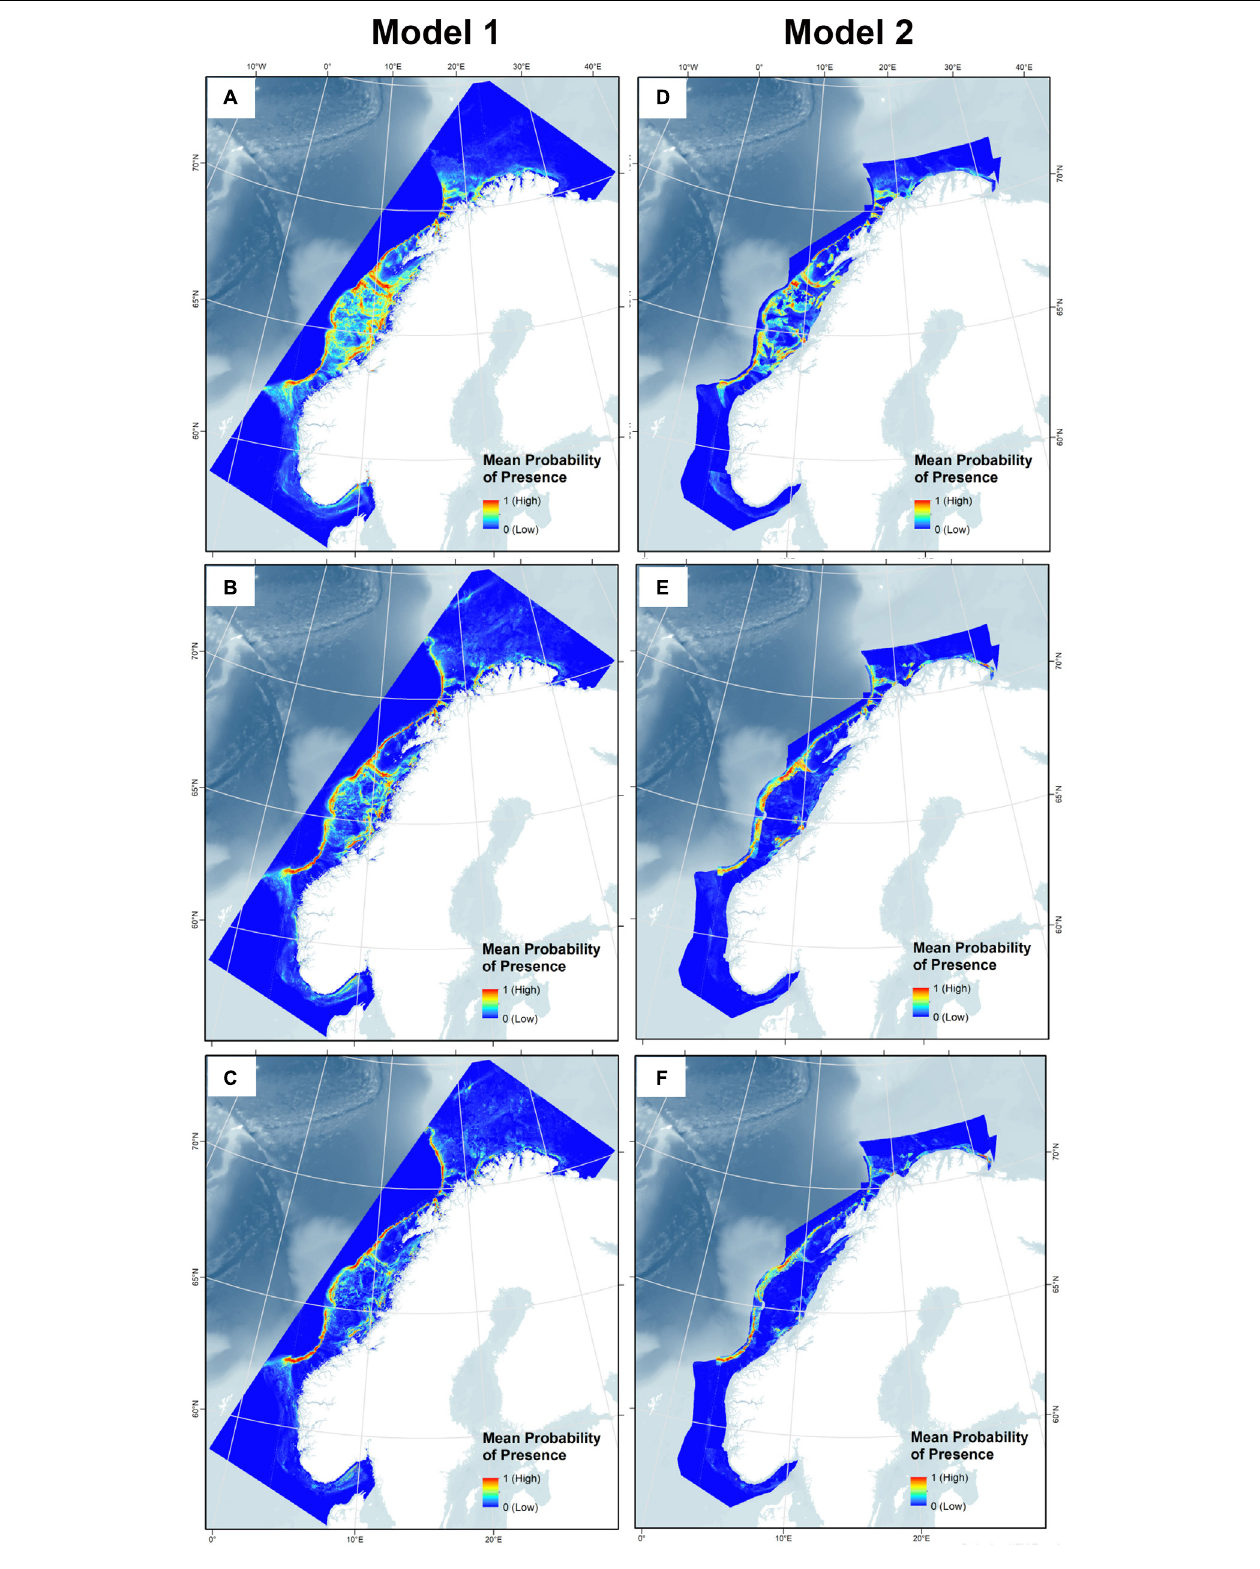
FIGURE 9 | Habitat suitability for Lophelia pertusa (A,D) , Paragorgia arborea (B,E) , and Primnoa resedaeformis (C,F) on the Norwegian continental shelf using Model 1 and 2.